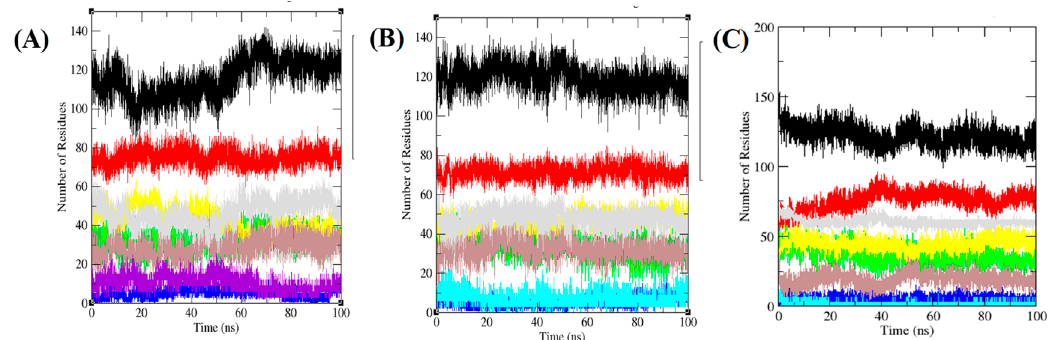
Figure 8. The decomposition of secondary structure of TmPLB1. The graphical depiction of secondary Figure 8. Secondary structure plot. Graphical representation indicating the structural elements present structural elements present in the TmPLB1 during the molecular dynamics (MD) simulations at ( A ) in the TmPLB1 during 100 ns MD simulations at ( A ) 30 ◦ C, ( B ) 35 ◦ C, and ( C ) 40 ◦ C, respectively. 30 °C, ( B ) 35 °C, and ( C ) 40 °C, respectively. The secondary structure elements represent α -helices, β - The structure represents α -helices, β -sheets, β -bridge and turns. The black, red, green, blue, yellow, sheets, β -bridge, and turns. Each structural element has been represented by different color such as brown, grey, and violet color represent overall structure, coil, β -sheet, β -bridge, bend, turn, α -helix, black ( β -sheet), red ( β -bridge), blue (bend), yellow (turn), brown ( α -helix) violet (3-helix) and violet and 3-helix, color represent overall structure respectively. Table 3. Percentage of residues participated in average structure formation.